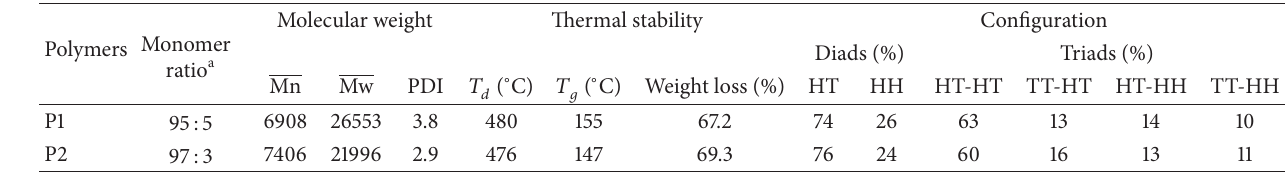
Figure 1: Structure of copolymers P1 and P2. Table 1: Polymers